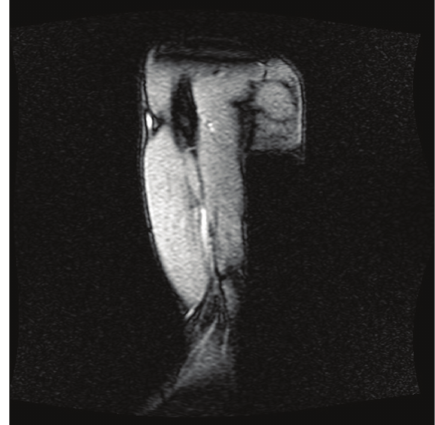
Figure 4: Same elbow, di ff erent